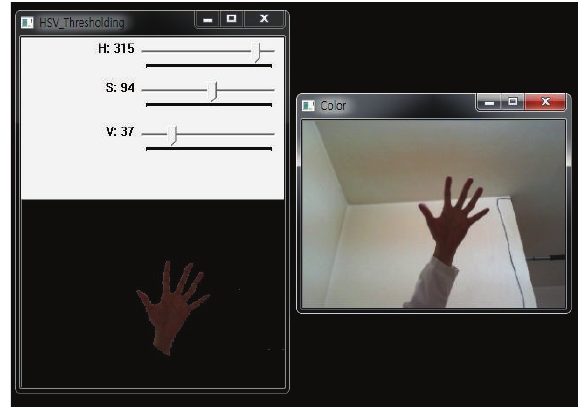
Figure 2: The procedure of hand